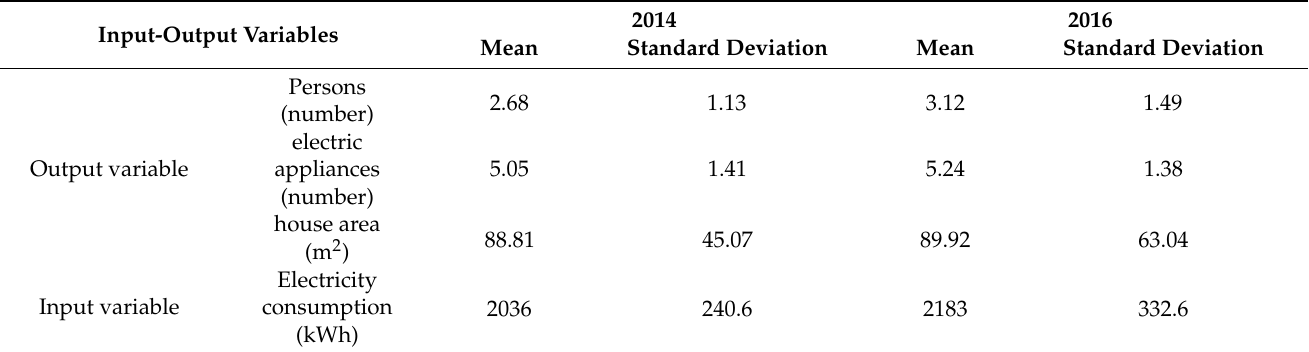
Table 1. Descriptive analysis of input-output